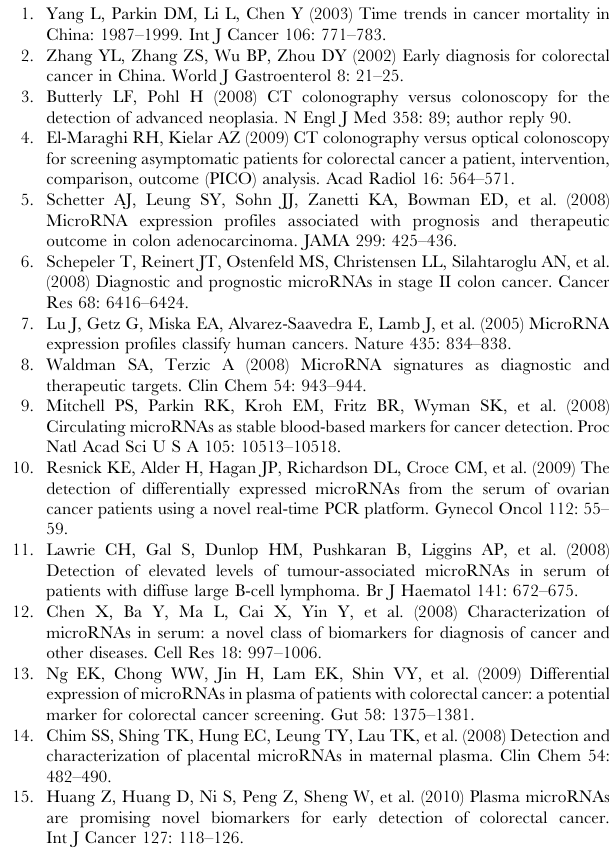
Figure S4 Diagnostic sensitivities of miR-601 and miR-